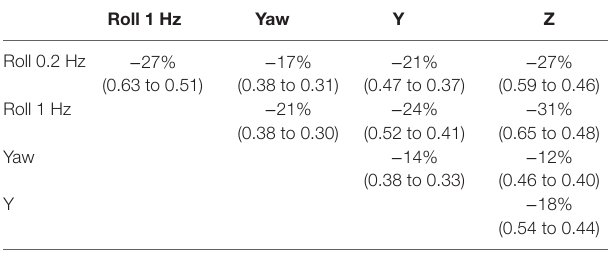
Differences shown for coefficients calculated across all subjects (r a